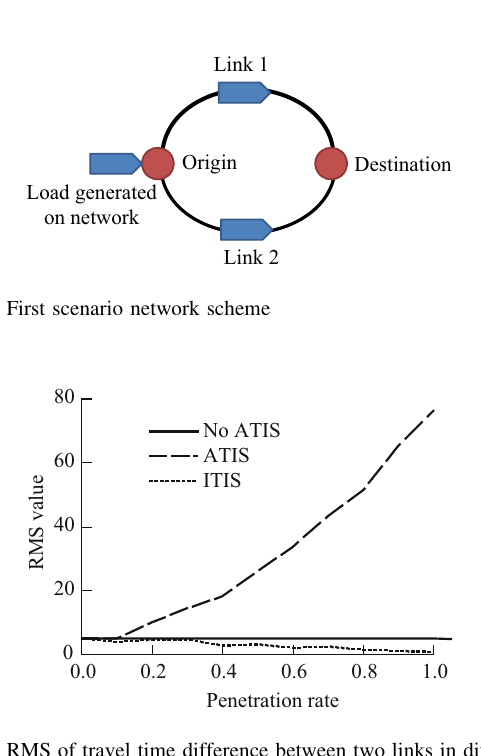
Fig. 6 RMS of travel time difference between two links in different information dissemination strategies for first